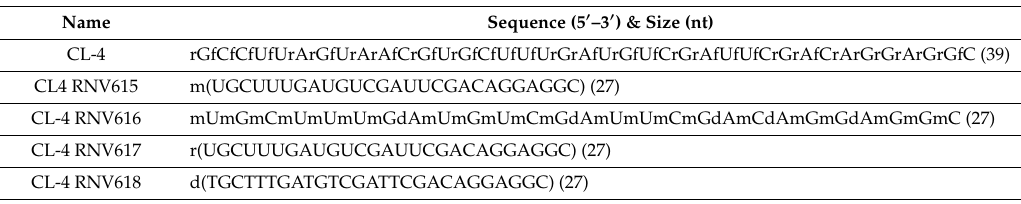
Table 1. Sequences of the truncated and chemically-modified epidermal growth factor receptor (EGFR) aptamers.